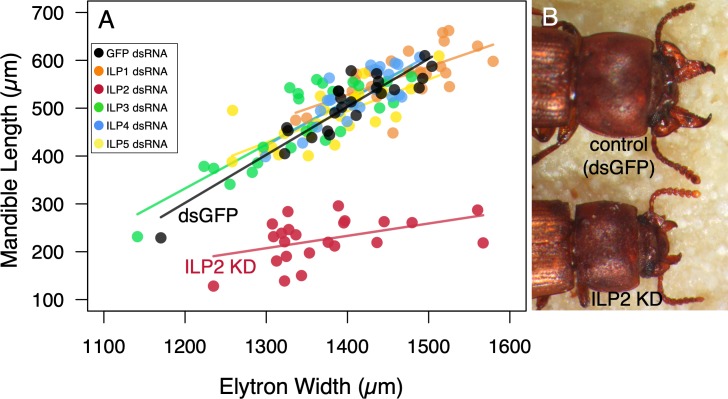
KD of a specific type of ILP (GcorILP2) diminishes conditional growth of male mandibles in G. cornutus.(A) KD phenotypes of 5 ILPs (Gcor1-5) shown as scatterplots of mandible length against body size (elytron width). Dots and regression lines of different treatments are shown by different colors. n = 24, 23, 24, 24, 24, and 24 for dsGcor1–5 and dsGFP, respectively. (B) GcorILP2RNAi males had smaller mandible size than the control males had. Two males had similar elytra sizes but clearly different mandible sizes and moderately different head and prothorax sizes. The underlying data in this figure are available from figshare (DOI: 10.6084/m9.figshare.9734780; https://figshare.com/s/609486022a3df39169bf). dsGFP, double-stranded RNA for GFP; dsRNA, double-stranded RNA; GcorILP2, G. cornutus ILP2; GFP, green fluorescent protein; ILP, insulin-like peptide; KD, knockdown; RNAi, RNA interference.